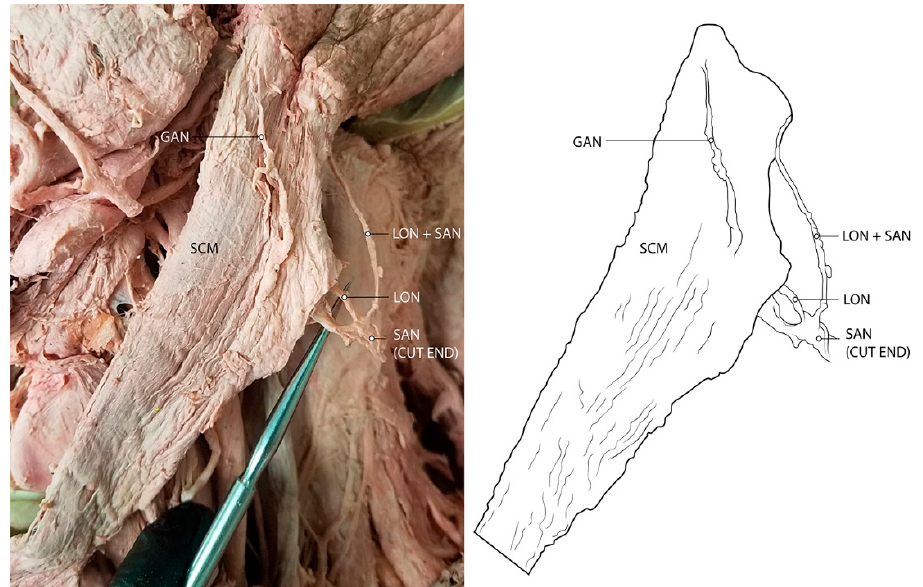
Figure 2. Cadaveric photo of connection between spinal accessory nerve (SAN) and lesser occipital nerve (LON), both of which pierce through the sternocleidomastoid. In this individual, the GAN also pierces the SCM, but does so separately from the SAN. Abbreviations: GAN = greater auricular nerve; LON = lesser occipital nerve; SAN = spinal accessory nerve; SCM = sternocleidomastoid.